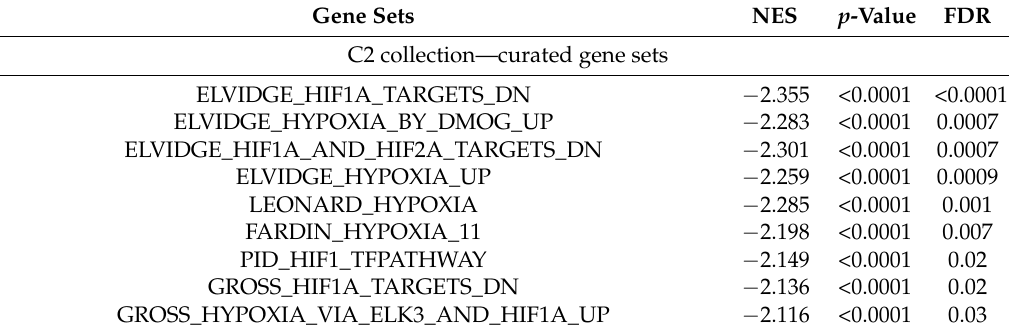
Figure 1. Lack of correlation between GBM-associated epilepsy and gene expression data. ( A ) Heatmap showing gene expression patterns of the 1000 RNA microarray probes with the highest standard deviation. Relative downregulation is shown as green, relative upregulation is shown as red, see color key. No differentially expressed genes were observed after correction for multiple testing (BH adjusted p < 0.05). ( B ) MiRNA expression patterns of the 100 probes with the highest standard deviation. 67 samples from our institute were included in this analysis. Relative miRNA downregulation is shown as white/yellow, and relative miRNA upregulation is shown as red, see color key. No differentially expressed miRNAs were observed after correction for multiple testing (Benjamini Hochberg adjusted p < 0.05). Table 1. Gene set enrichment analysis with MSigDB collections. Gene sets are significantly downregulated in the epilepsy group compared to the patients without epilepsy. Cutoff values for significance were p < 0.05 and FDR < 0.25. Analyses were performed with MSigDB collections C1–C7. A subset of significant C2 results were displayed in this table. See supplementary Table S1 for full results with the C2 collection. NES: normalized enrichment score, FDR: false-discovery